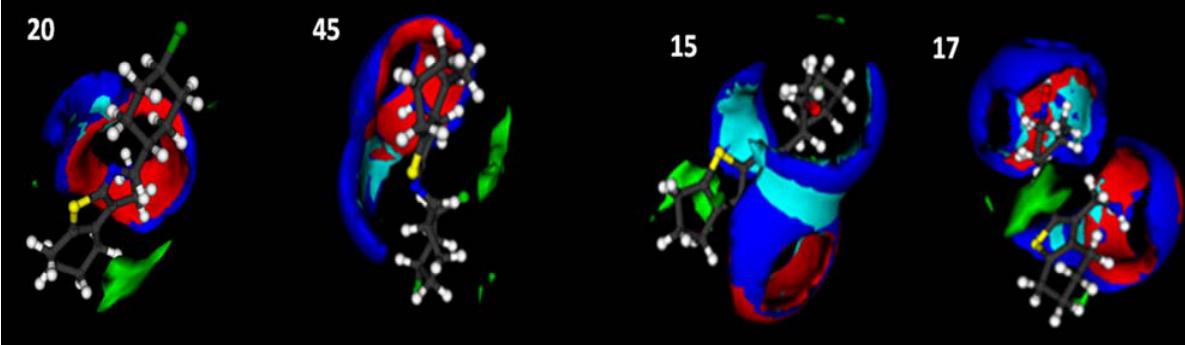
Figure 3. Maps of interaction with the probes H2O, N1 and O obtained for inactive compounds 20 and 45 and for active compounds 15 and 17